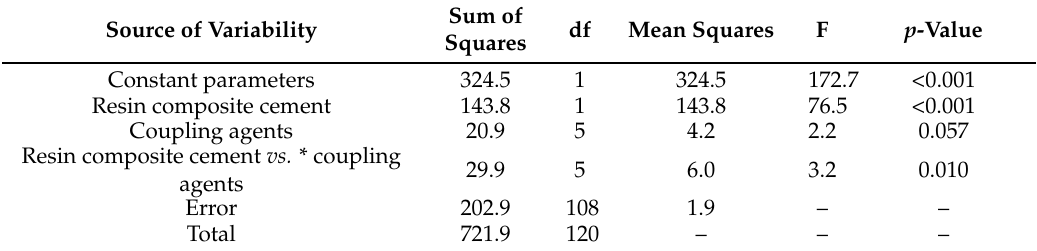
Table 3. Two-way ANOVA results for comparison of retention strength for different coupling agents and resin composite cements and their interaction denoted by